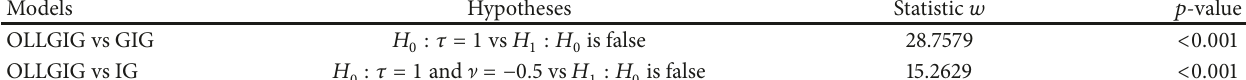
Table 10: LR tests for the price of urban property data.